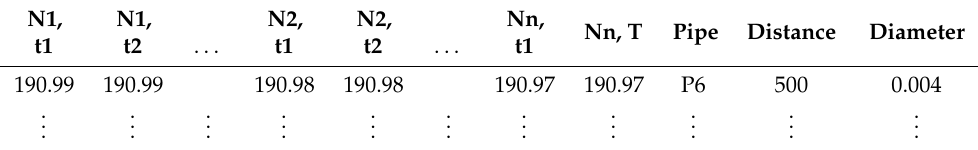
Table 1. The structure of the